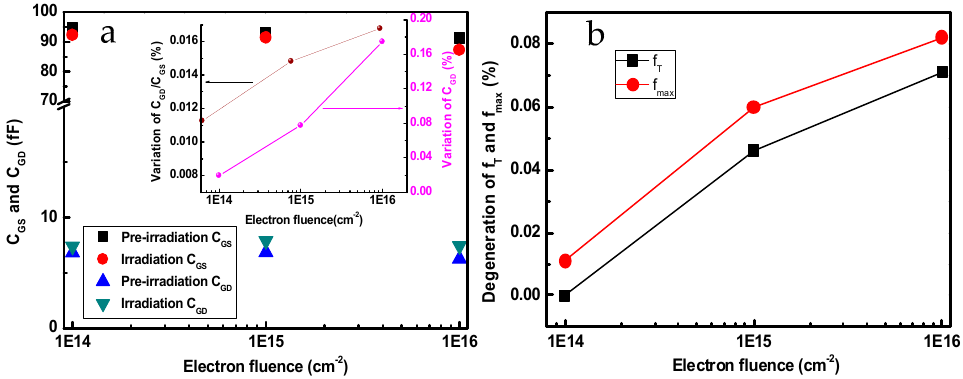
Figure 8. ( a ) Dependence of C GS and C GD on electron fluences, ( b ) degradation percentage of f T and f max as a function of electron fluence.